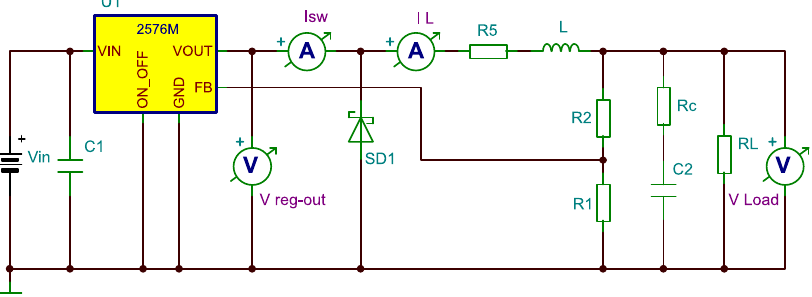
Figure 4. Electrical wiring diagram of the buck DC – DC converter with the LM2576 regulator model.